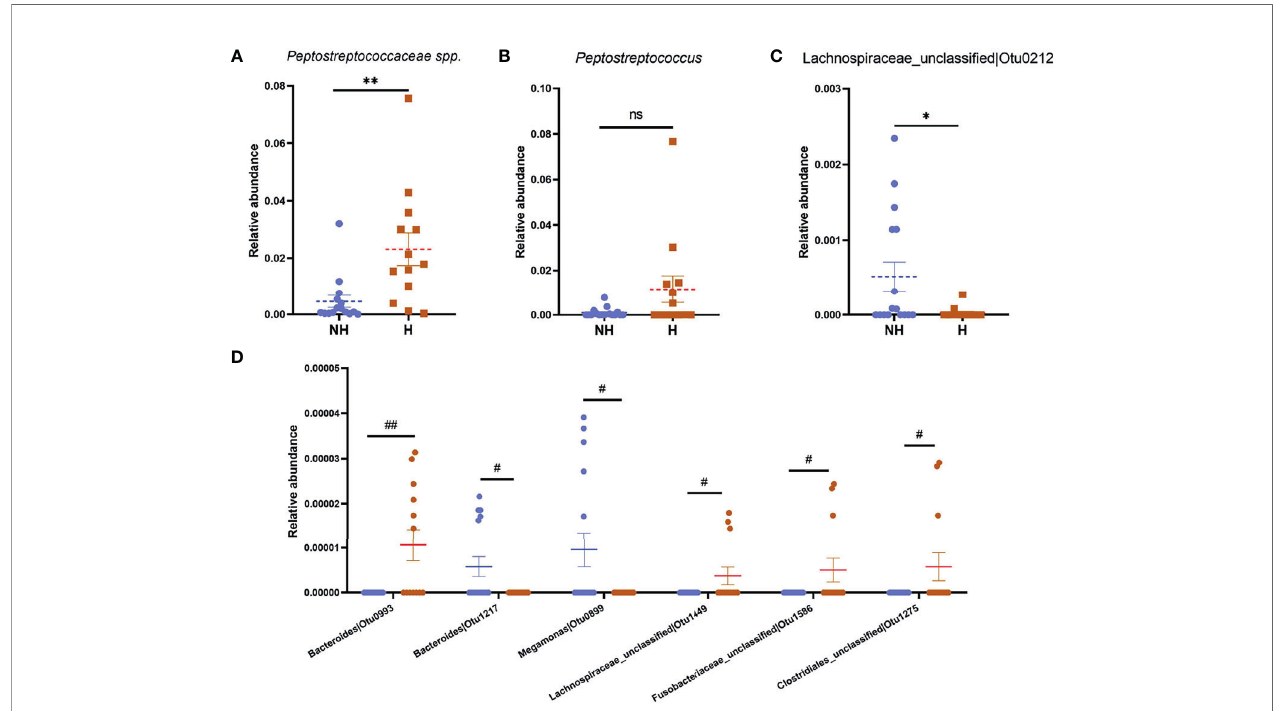
FIGURE 5 | Signi fi cantly differential relative abundance of bacteria in Heamafecia patients. The relative abundance of Peptostreptococcaceae species (A) , Peptostreptococcus OTU45 (B) and Lachnospiraceae OTU212 (C) are shown. 4 OTU were unique in H group while 2 OTU were found in NH group (D) . Error bars indicate SEM. Blue dots: Relative abundance of bacteria in NH; brown squares: Relative abundance of bacteria in H group. ns, not signi fi cant, * p < 0.05, ** p < 0.01, # qFDR < 0.1, ## qFDR <